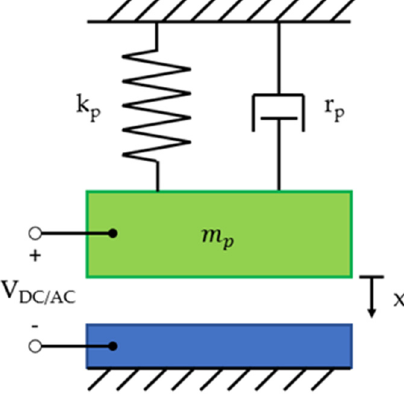
Figure 2. Mass-spring-damper model of a CMUT [49].